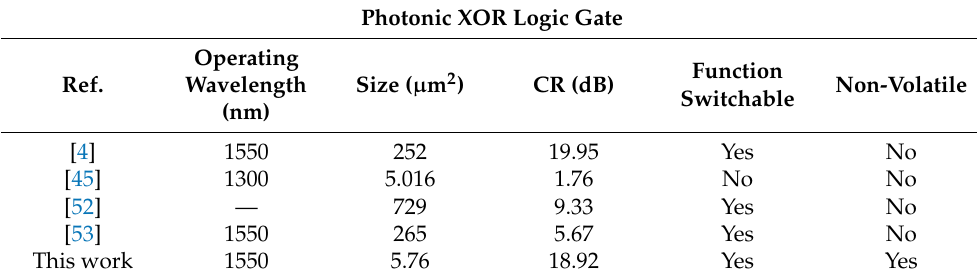
Table 8. Performance comparison between the proposed photonic XOR logic gate and several reference structures reported in other